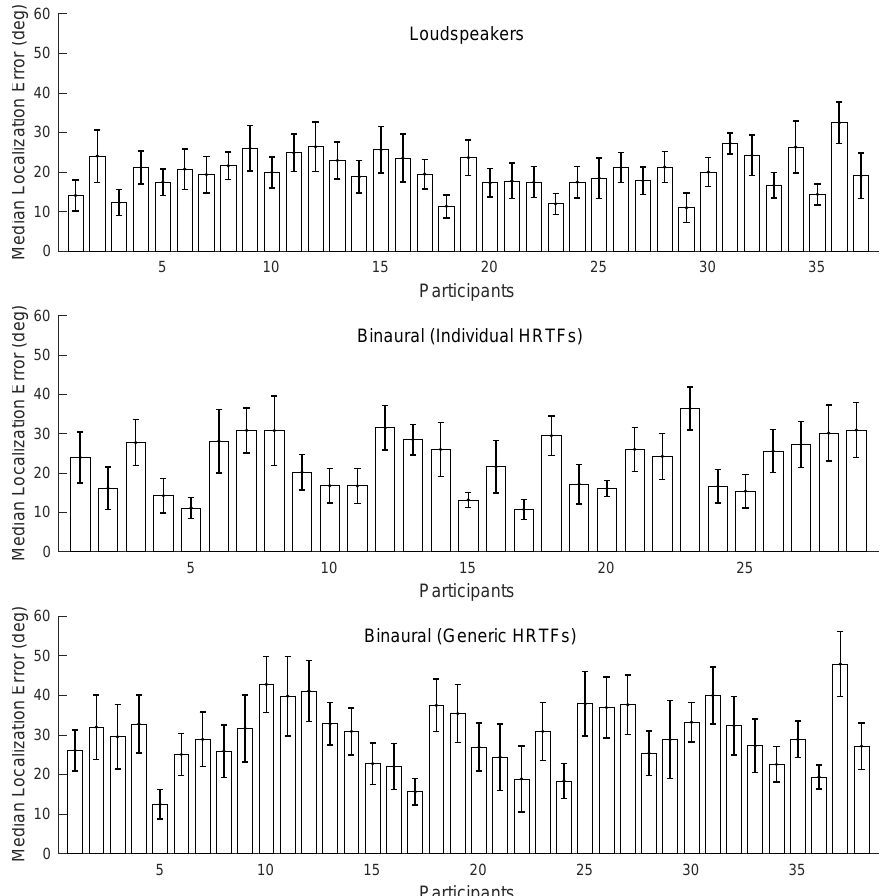
Figure A1. Median localization error of each participant at different reproduction methods. The whiskers indicate non-parametric 95% confidence intervals